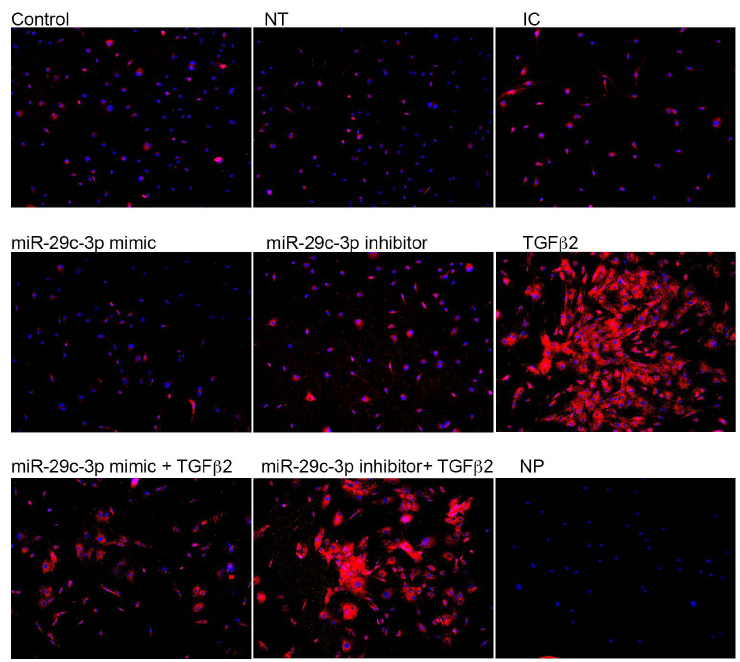
Figure 6. TGF β 2 and miR-29c-3p regulate collagen IV protein expression in LC cells. Primary human LC cells were transfected with miR-29c-3p mimic (10 nM), inhibitor (10 nM, inhibitor control (IC; 10 nM), or non-targeting (NT; 10 nM) control in the presence or absence or TGF β 2 (5 ng/mL) for 72 h. Cells were fixed and immunolabelled with anti-collagen type IV antibody (red). Nuclei (blue) were stained with DAPI. NP = no primary Ab control. Representative images are shown. Images taken at 100 ×